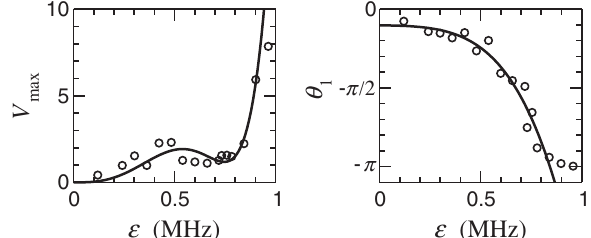
FIG. 1. Maximum ratchet velocity v functions of the amplitude (cid:2) ¼ (cid:2) for the rocking ratchet of Ref. [24]. Points are the experimental data, and lines are fits to formula (10): (cid:5)